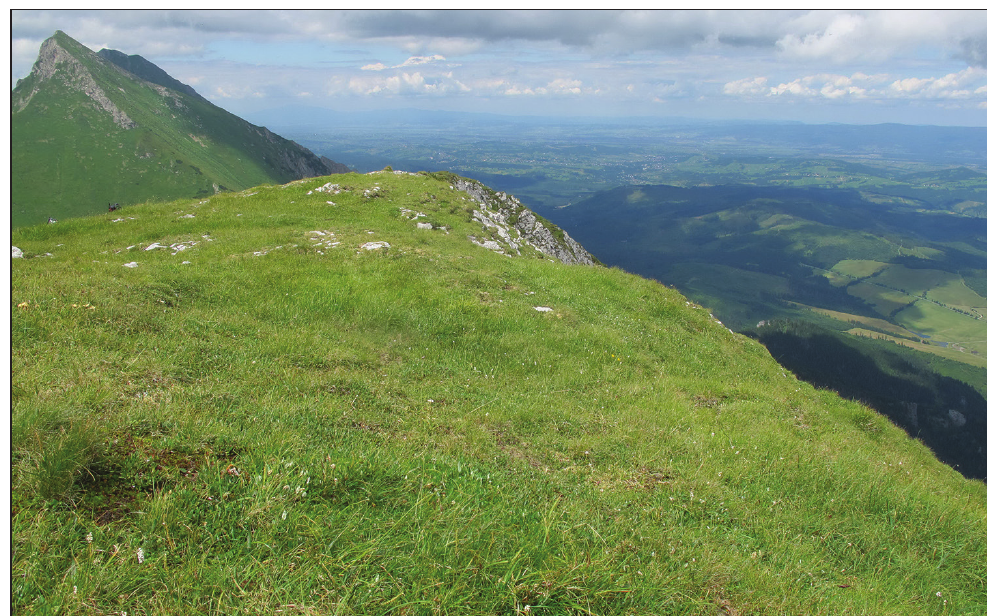
Figure 8. The Belianske Tatra Mts, Zadné Jatky Mt., 30.vii.2016, type locality of Stigmella tatrica . Photo- graph Z. Tokár.